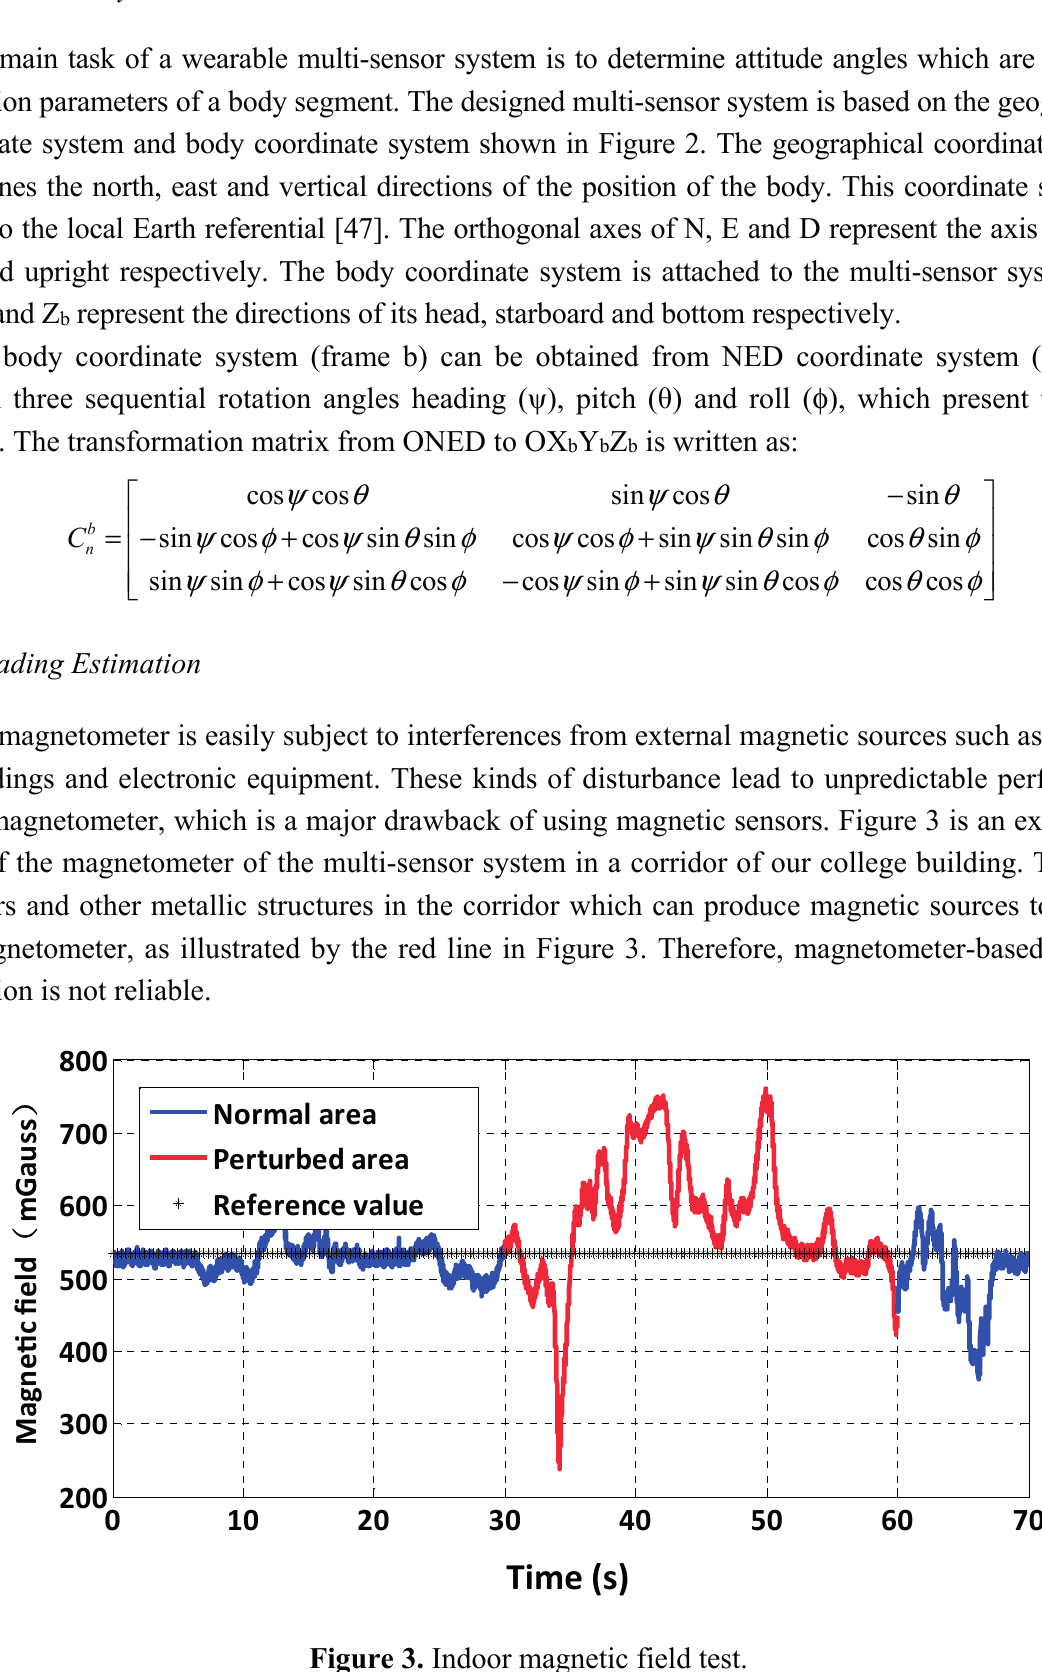
Figure 3. Indoor magnetic field